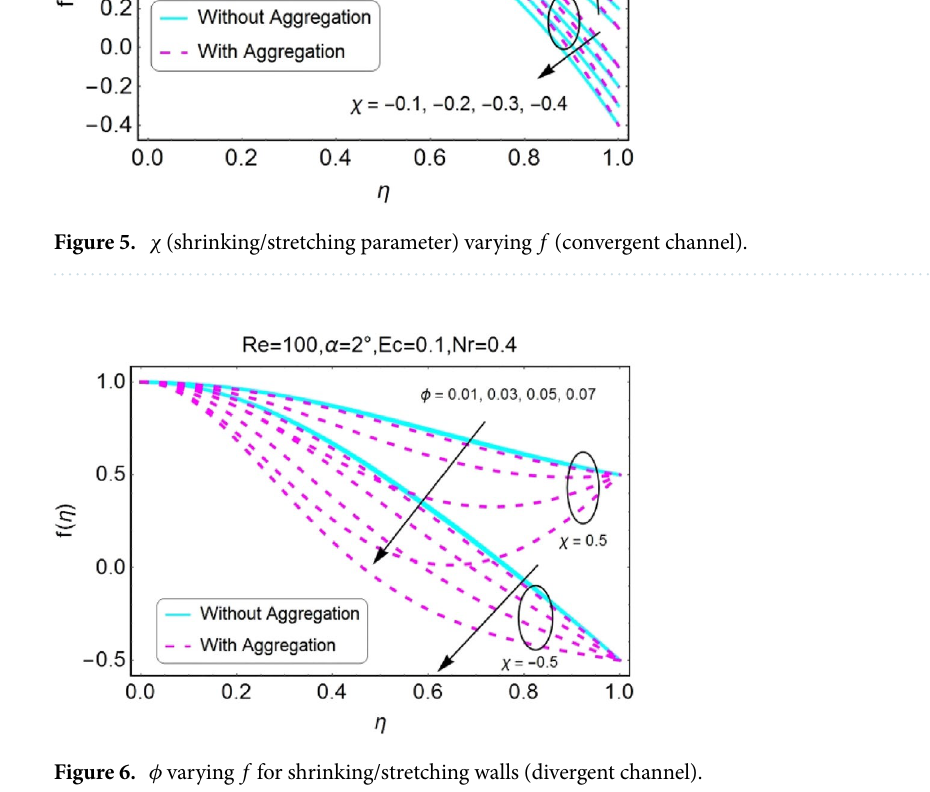
Figure 6. φ varying f for shrinking/stretching walls (divergent